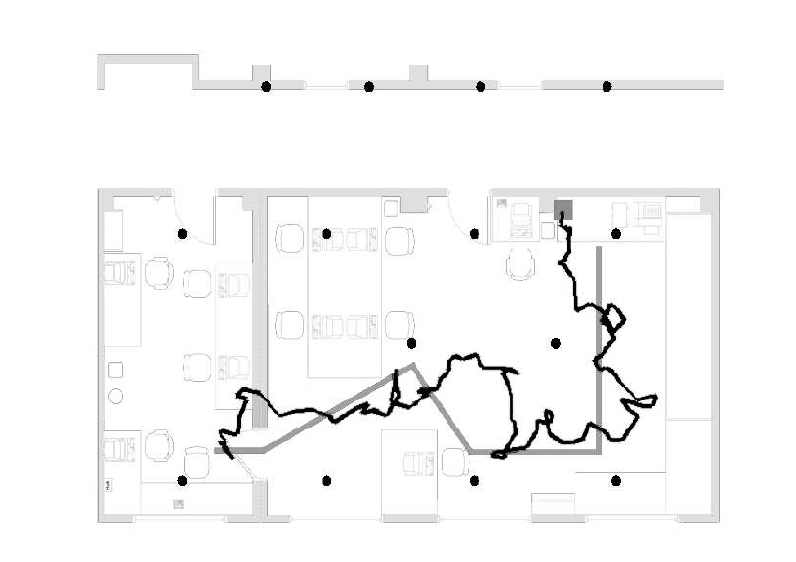
Figure 13. Tracking experiment. The reconstructed path is represented with a black solid line; the actual path is shown with a solid light grey line. The sensor nodes of the fixed network are represented with black